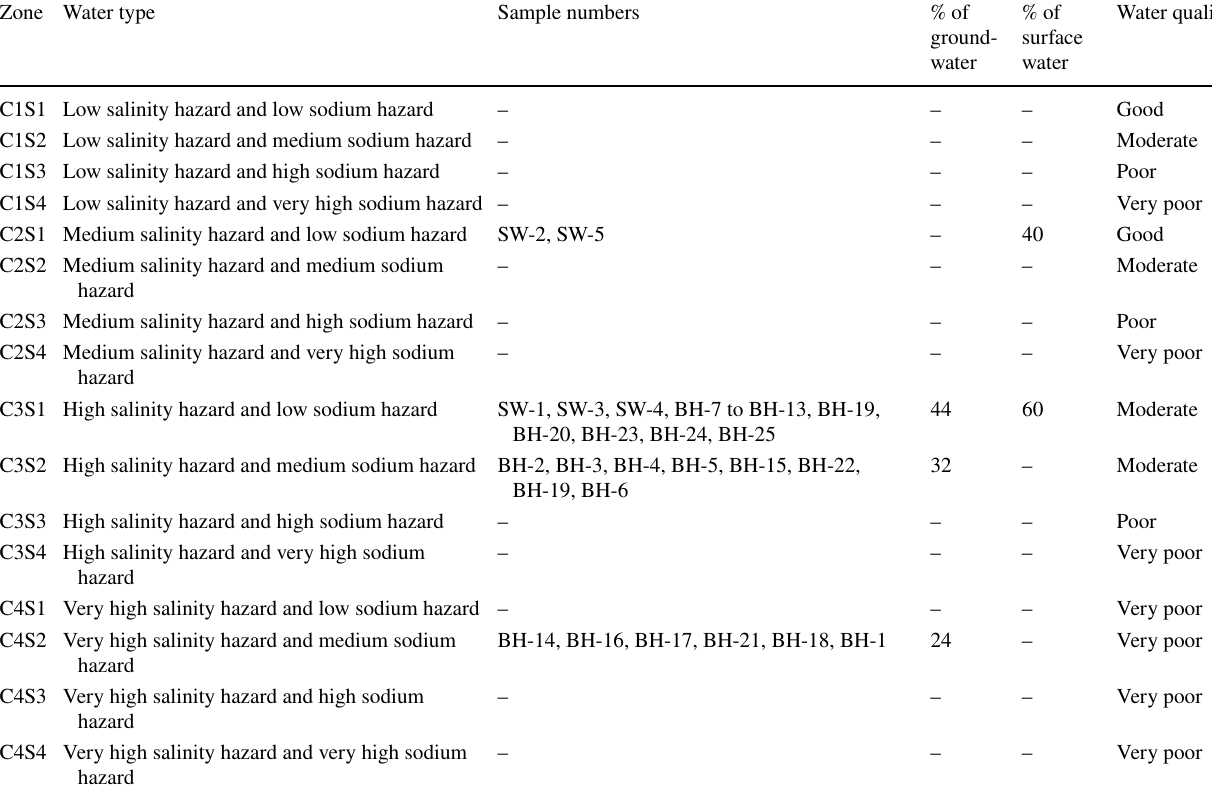
Table 10 Criteria for water quality for irrigation following the (US Salinity Laboratory Staff 1954), in Mothkur region, Telangana State, South India